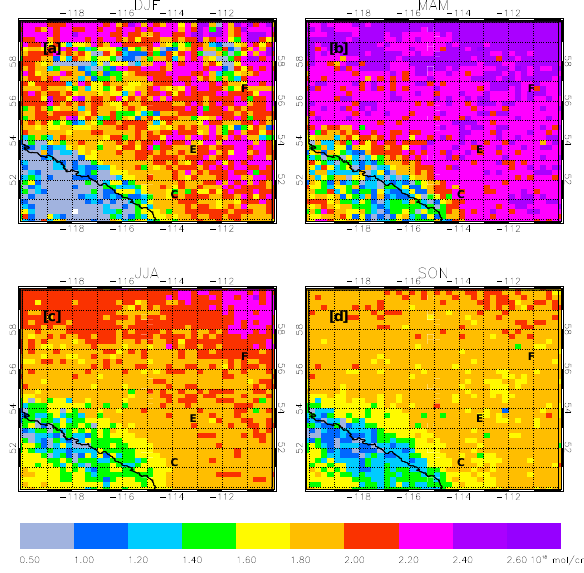
Figure 2. The MOPITT daytime CO total column measurements over Alberta for the period March 2002 to December 2013 in (a) winter, (b) spring, (c) summer, and (d) fall. The symbols F, E, and C represent the cities of Fort McMurray, Edmonton, and Cal- gary, respectively. Data are gridded at 0.25 × 0.25 ◦